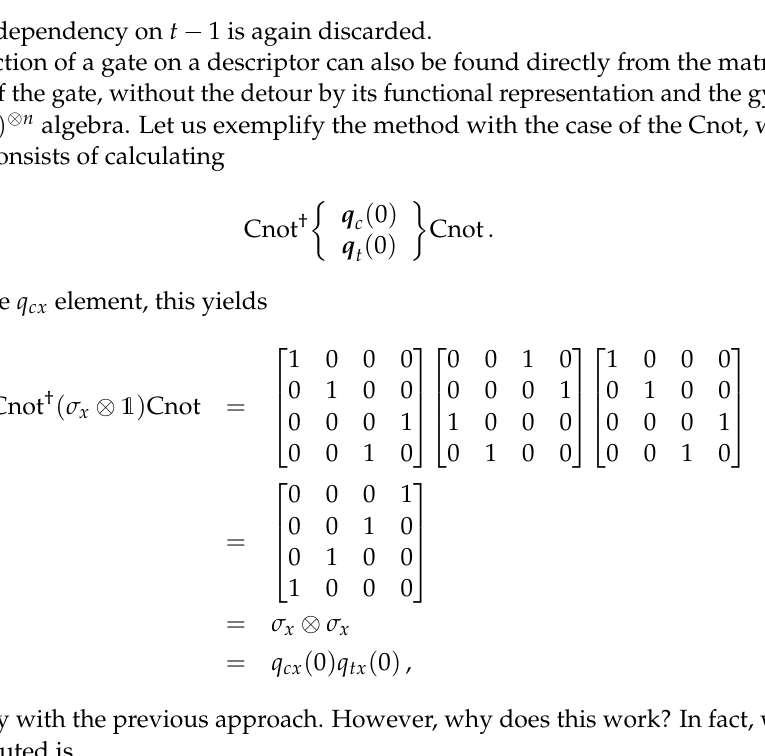
(cid:12) (cid:11) = | 00 (cid:105) + | 11 (cid:105) √ (cid:12) Φ +